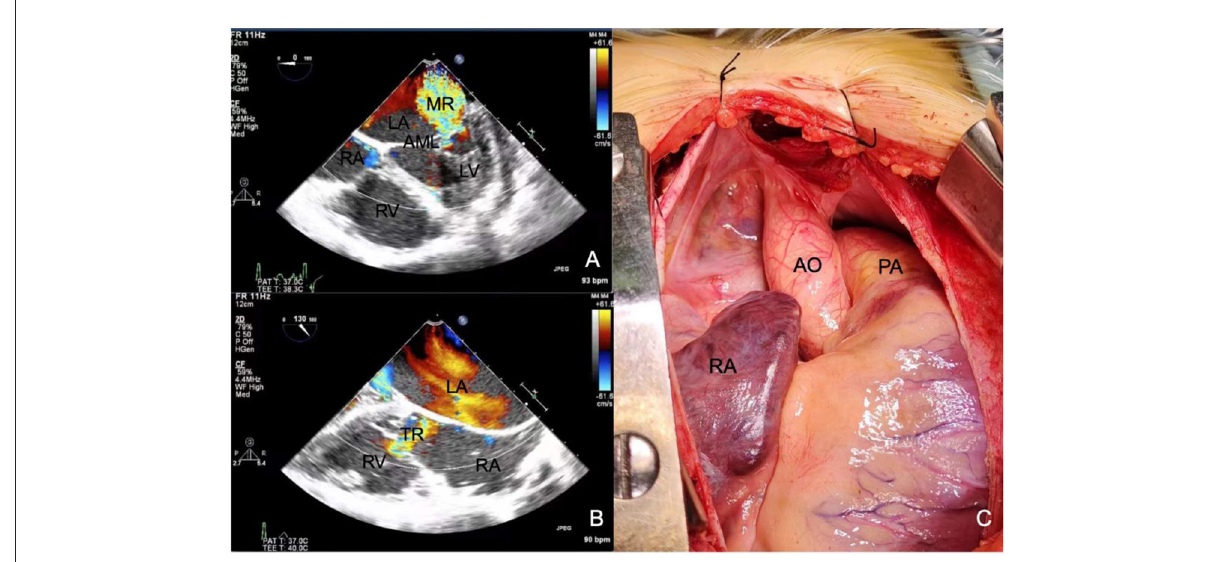
FIGURE4 Echocardiography shows (A) severe mitral regurgitation and (B) severe tricuspid regurgitation. (C) Intraoperative photographs show that the aorta is 1.5cm in diameter, which is significantly smaller than normal. RA, right atrium; RV, right ventricle; LA, left atrium; LV, left ventricle; AML, anterior mitral leaflet; MR, mitral regurgitation; TR, tricuspid regurgitation; AO, aorta; PA, pulmonary